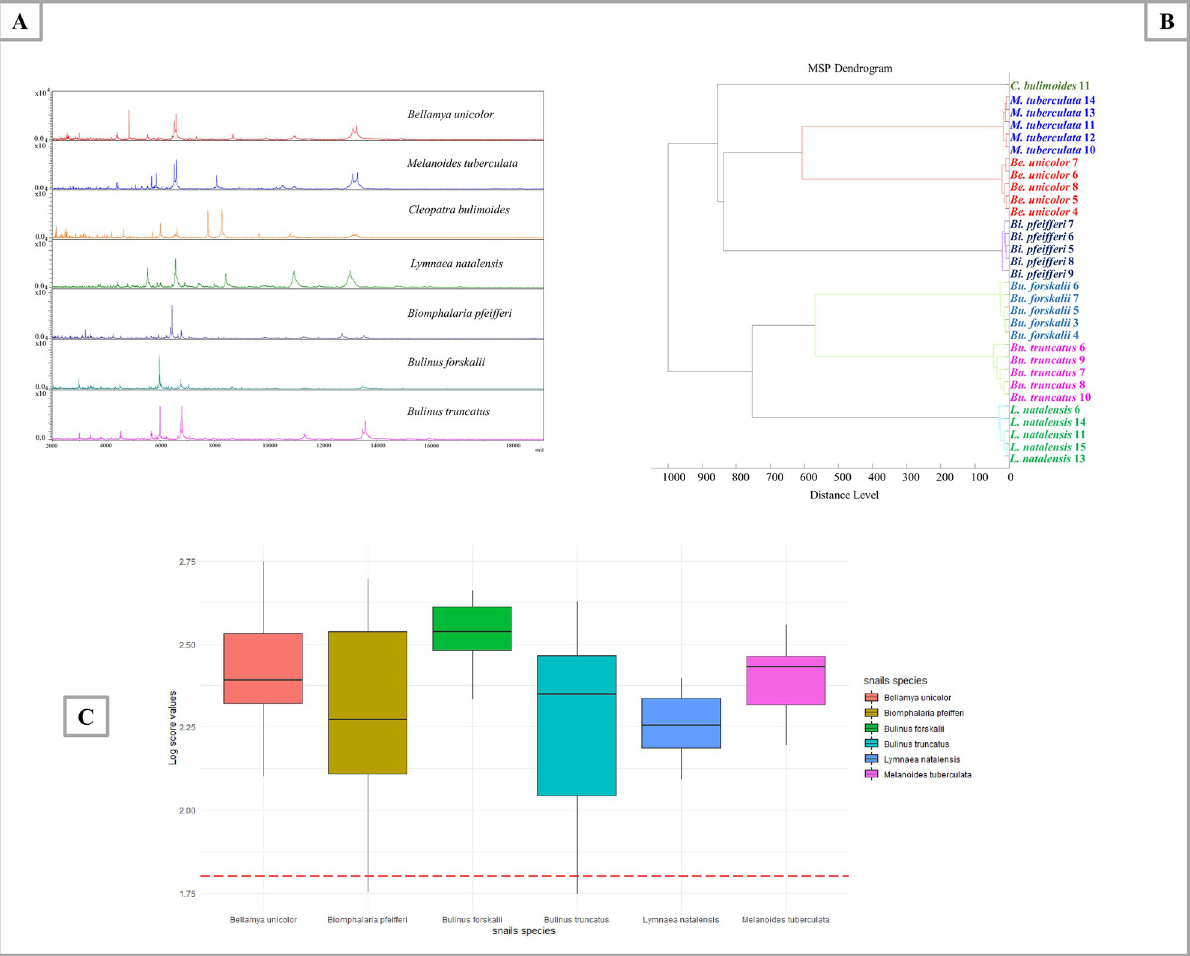
Fig 4. MALDI-TOF MS spectra obtained from different snail species to create the database. (A) Spectral alignment of seven snail species showing discriminative peaks using Flex Analysis software; smoothed spectra with baseline subtracted. (B) dendrogram of MALDI-TOF MS spectra of snail species collected in Senegal. Cluster analysis was performed using Biotyper software v.3.0. (C) Graphical representation showing the log-score values classification according to the following species: Bu . forskalii , Bu . truncatus , M . tuberculata , Be . unicolor , L . natalensis and Bi . pfeifferi .